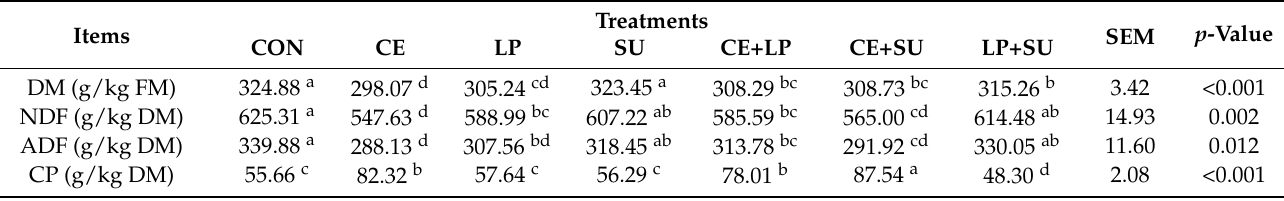
Table 2. Nutrient composition of hybrid Pennisetum silage.